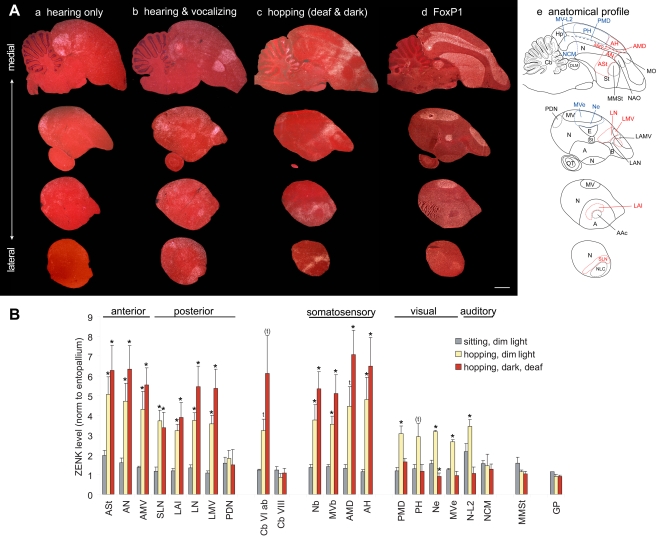
Movement-induced ZENK expression in budgerigars, a parrot.A. Serial sagittal sections of: (a) Auditory areas: bird sitting relatively still while hearing playbacks of budgerigar warble song; (b) Auditory and vocal areas: perched bird hearing himself and producing warble song while alone and moving relatively little; (c) Movement areas: bird hopping in the rotating wheel in the dark while deaf; (d) FoxP1 expression from adjacent sections of the bird in (c); (e) Corresponding anatomical drawings; red: areas with movement-induced expression; blue: areas with auditory- or visual-induced expression. First row are medial-most sections. Sections with N-L2 are not shown. Anterior is right, dorsal is up. Scale bar, 2 mm. Compare with frontal sections in figure S6. B. Quantification of ZENK expression levels in 22 different brain regions in three groups of budgerigars. * = p<0.05 to<0.0001, one-way ANOVA followed by Holm-Sidak multi-comparison test relative to the sitting still group (n = 3/group). t = significantly different, p<0.05, by a t-test. (t) = 0.06<p<0.09 by a t-test. Although the cerebellum lobule VI clearly had high levels of induced expression in all three animals of the hopping, dark, deaf group, this difference approached significance (p = 0.06) due to a large variance; the same was true of the PH region in the hopping, dim light group. Error bars, S.E.M.